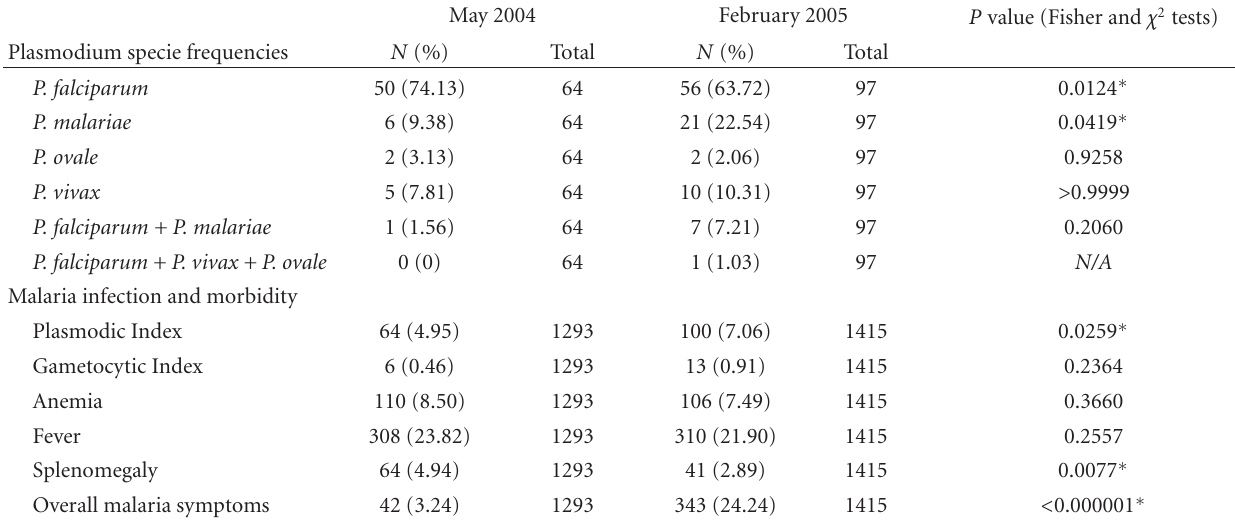
Table 3: Malaria infection prevalence and morbidity in May 2004 and February